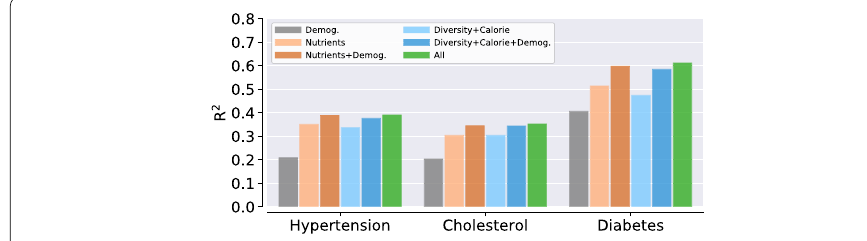
Figure 8 R 2 values of regressions having different combinations of features